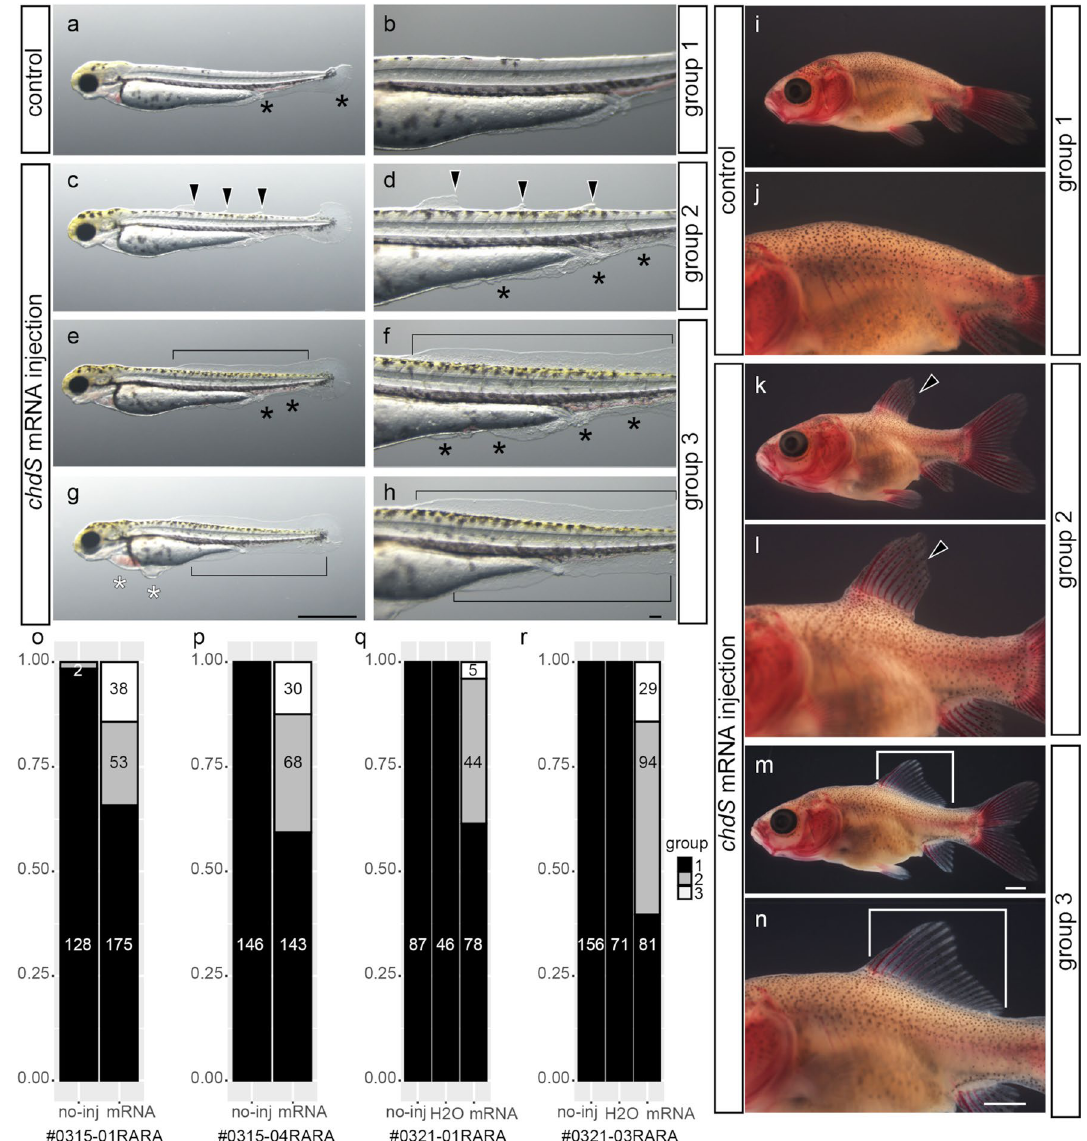
Figure 3. Rescue of the dorsal-finless phenotype by mRNA microinjection. (a – h) Representative phenotypes of hatched larvae (3dpf). Control ( a , b ) or chdS wt mRNA injected hatched larvae ( c - h ) (arrowheads, partially rescued dorsal fin fold; black bracket, completely rescued fin fold; black asterisks, mutated fin fold at the ventral side; white asterisks, malformation of the anterior ventral side tissues). Panels of ( b , d , f and h ) are magnified views of ( a , c , e , and g ), respectively. Hatched larva exhibiting group 1 ( a , b ), group 2 ( c , d ) or group 3 ( e – h ) phenotypes. ( i – n ) Late larvae. Control ( i , j ) and chdS wt mRNA injected late larvae ( k – n ). Panels of ( j , l ) and ( n ) are magnified views of ( i , k ), and ( m ), respectively (black arrowhead, partially rescued dorsal-fin; white bracket, completely rescued dorsal fin). Late larvae on panels on ( i , k ), and ( m ) are derived from the hatched larvae of group 1, group 2, and group 3, respectively. ( o - r ) Proportion of rescued specimens following injection of embryos with the wild type chdS mRNA (chi-squire test p < 0.0001 in all clutches). Scale bars = 0.1 mm ( h ), 1 mm ( g , m , n ). Panels of hatched larvae ( a , c , e , g ), the magnified views of the hatched larvae ( b , d , f , h ), late larvae ( i , k , m ), and the magnified view of the late larvae ( j , l , n ) are shown at the same the median fin fold were related to the dorsal fin morphology at the late larval stage (Fig. 3i–n). All of the control hatched larvae exhibited a relatively uniform ventralized phenotype (e.g., bifurcated and/or disrupted fin folds at the ventral side and enlarged blood island), as described in chordin -depleted teleost species, in addition to a reduced dorsal fin fold from the caudal to mid-trunk level (equivalent of yolk extension region) (Fig. 3a,b) 11,17–19 . On the other hand, the mRNA-injected larvae exhibited various phenotypes (Fig. 3c–h). A number of the hatched larvae exhibited rescue of the median fin fold phenotype at both dorsal and ventral sides after microinjection of the mRNA. This rescue was consistent with our previous mRNA rescue experiment, although several hatched larvae exhibited malformations in the heart and the epithelial tissues at the anterior regions (Fig. 3g,h) 11,20 .